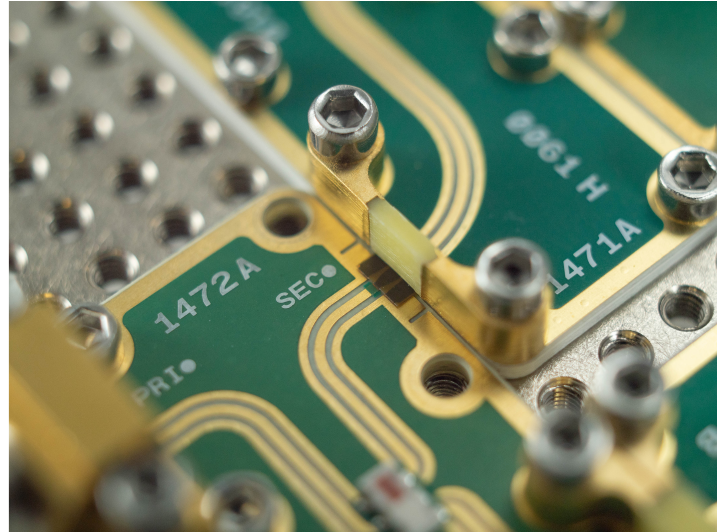
Figure 11. Detail of the solderless PCB interconnection with one of the two gsg jumper anchors